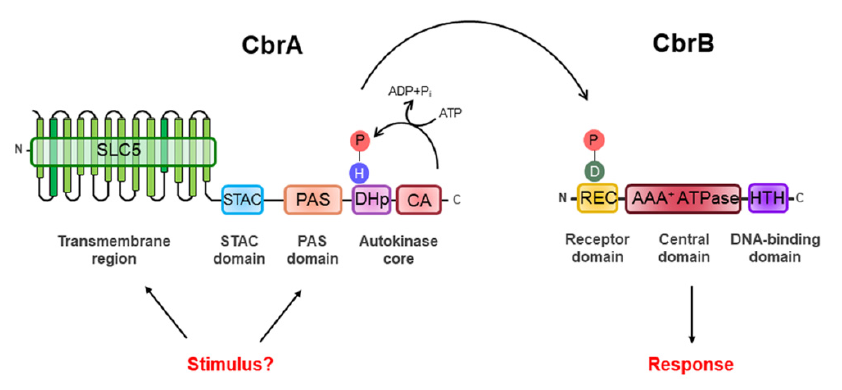
Figure 1. Schematic representation of the TCS CbrAB system in Pseudomonadaceae . The histidine kinase CbrA bears two domains susceptible to detect an environmental signal (SLC5 domain and PAS domain). Stimulus detection modulates autophosphorylation at a highly conserved histidine residue located in the dimerization and phosphotransfer domain (DHp) in an ATP-dependent reaction catalyzed by the catalytic domain (CA). Immediately, CbrA transfers the phosphoryl group to a conserved aspartic residue in the REC domain of CbrB. Phosphorylation of CbrB promotes its oligomerization and binding to the promoter regions of its regulon through the DNA-binding domain.